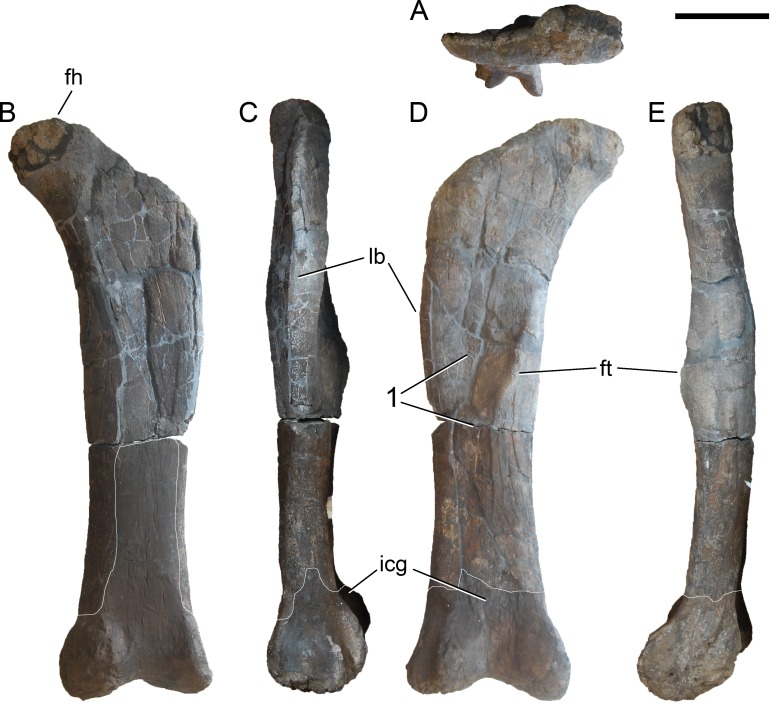
Left femur of Galeamopus pabsti SMA 0011.The femur is shown in proximal (A), anterior (B), lateral (C), posterior (D), and medial (E) view. Note the rugose tubercles on the posterior surface of the shaft (1). The distal end is restored, and parts of the distal anterior surface are covered with epoxy for the mounting (indicated by white lines). Abb.: fh, femoral head; ft, fourth trochanter; icg, intercondylar groove; lb, lateral bulge. Scale bar = 20 cm.